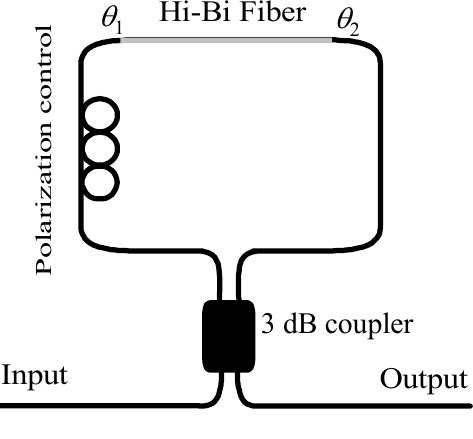
Figure 1. Schematic of a Hi-Bi fiber loop